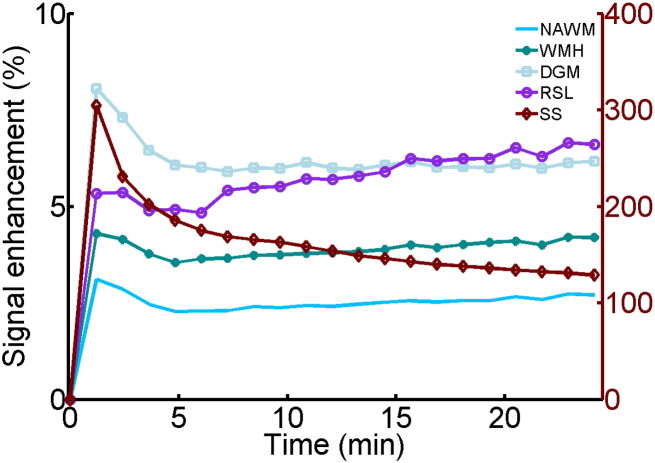
Cohort average signal enhancement curves. Post-contrast signal enhancement versus time obtained from the median signal intensity in each tissue type (NAWM: normal-appearing white matter, WMH: white matter hyperintensities, DGM: deep grey matter, RSL: recent stroke lesion, SS: sagittal sinus) and averaged over all patients (n = 201). Y-axis scales for the tissue and sagittal sinus enhancement curves are shown on the left and right, respectively.